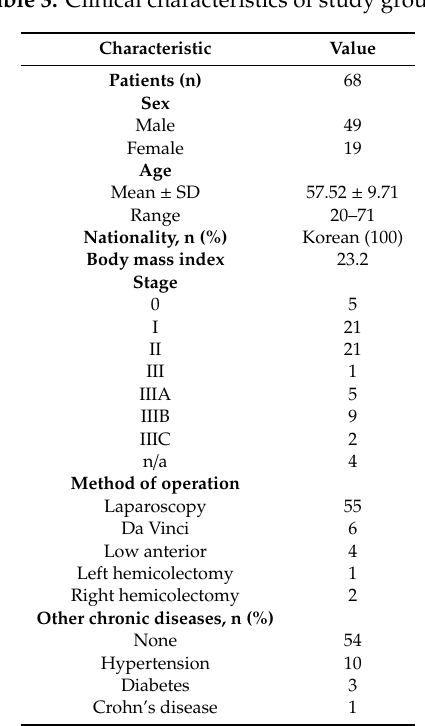
Table 3. Clinical characteristics of study